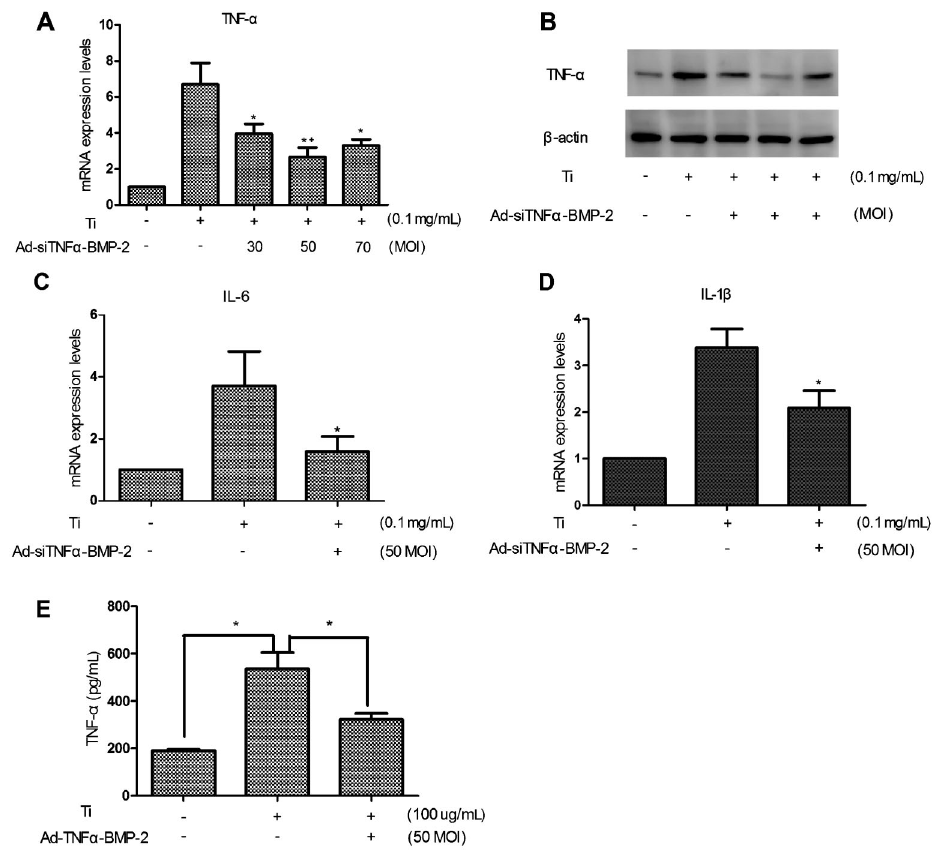
Figure 2. Suppression effects of Ad-siTNF a -BMP-2 on titanium particle-induced inflammatory factor. A , RAW264.7 cells were plated on 6- well cluster plates at a density of 4 6 10 5 cells/well. After 24 h, RAW264.7 cells were treated with or without Ti particles in the presence or absence of Ad-siTNF a -BMP-2 for 48 h. There was a significant reduction of TNF- a mRNA expression at 50 MOI . B , TNF- a protein levels detected by Western blot after 48 h. There was significant reduction of IL-6 ( C ) and IL-1 b ( D ) mRNA expression byAd-siTNF a -BMP-2 at 50 MOI. E , TNF- a protein levelsdetected byELISAwhentreated with 0.1 mg/mLTiparticles ora combinationof0.1 mg/mLTi particlesand50 MOI Ad-siTNF a -BMP-2 for 24 h. Data are reported as means±SD. Similar results were obtained in three independent experiments. MOI: multiplicity of infection. *P , 0.05, compared to the cultures with Ti particles only; + P , 0.05, compared to 30 MOI (one-way